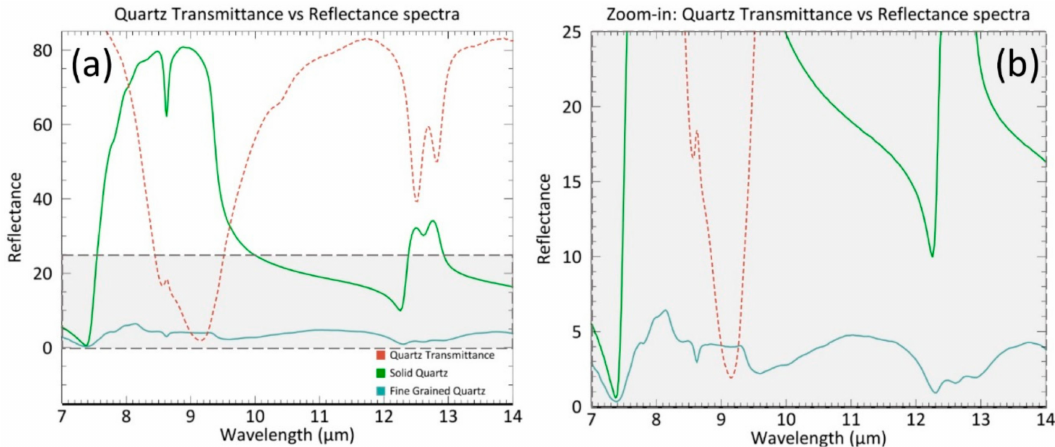
Figure 2. ( a ) The effect of transmittance in quartz (red spectrum) on the reflectance spectrum. The green spectrum represents a quartz spectrum that has not been influenced by transmittance. The blue spectrum is a quartz spectrum of a fine-grained, particulate quartz sample (<60 µ m) that is significantly affected by transmittance bands [16]. ( b ), a subset of ( a ), shows a lowered spectral reflectance in bands that are most influenced by low transmittance. Spectra are from Johns Hopkins University (JHU) and can be found in the ASTER spectral library in ENVI